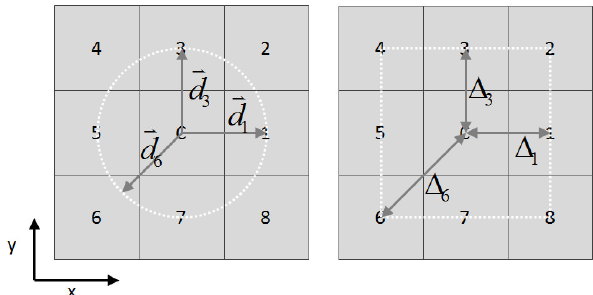
, − 1 √ ), (cid:49) 1 = 1, 2 2